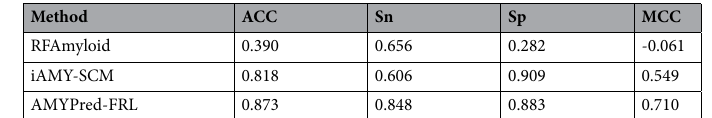
Table 6. Performance comparison of AMYPred-FRL with the two state-of-the-art methods on as evaluated on the independent test. Performance of RFAmyloid and iAMY-SCM were obtained by feeding protein sequences from the independent dataset to their web servers (accessed on 7 July